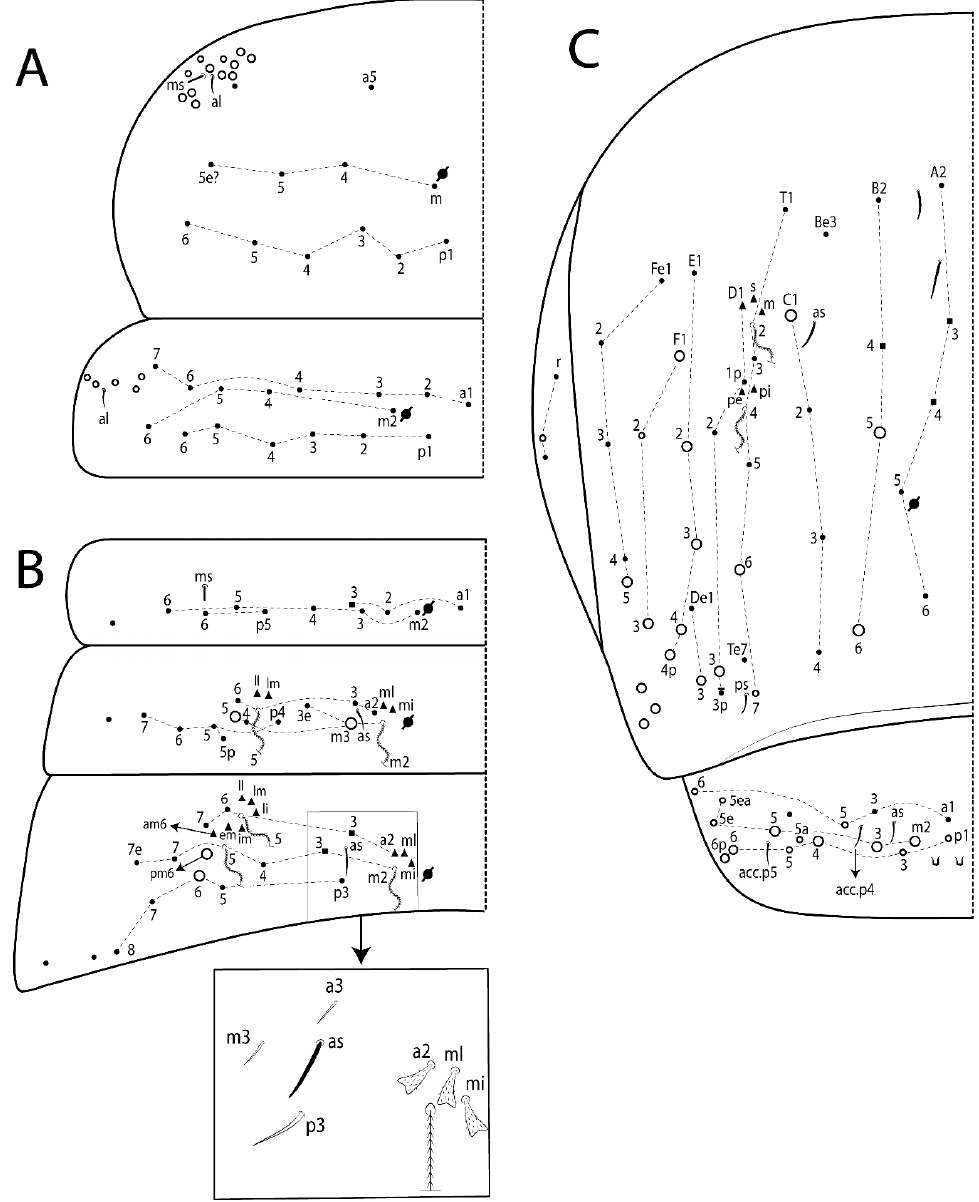
Figure 9. Pseudosinella acantholabrata sp. nov.: dorsal chaetotaxy. ( A ) Th II–III; ( B ) Abd I–III, arrow indicates part of Abd III central chaetotaxy; and ( C ) Abd IV–V.